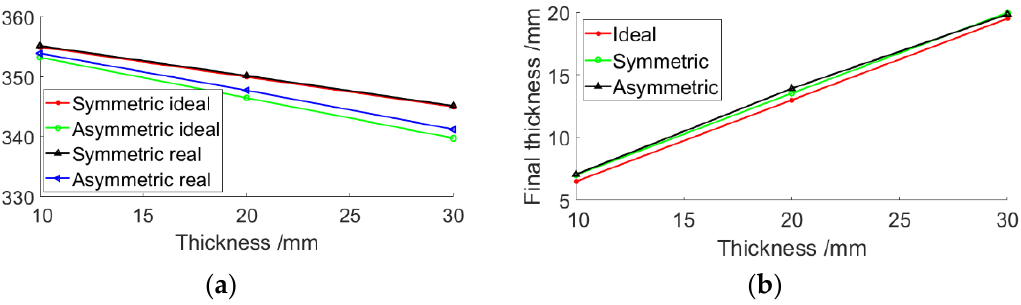
Figure 12. The influence of the tube blank thickness on the final tube shape: ( a ) Middle radius; ( b ) Final thickness. (ideal: ideal situation; real: real situation.).